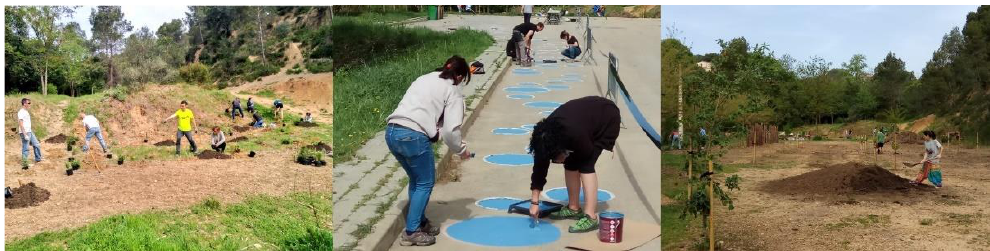
Figure 7. Intervention in the surroundings of the spring, with the participation of the locals (clearance of rubbish, painting of circles on the car park surface, and tree and shrub planting).